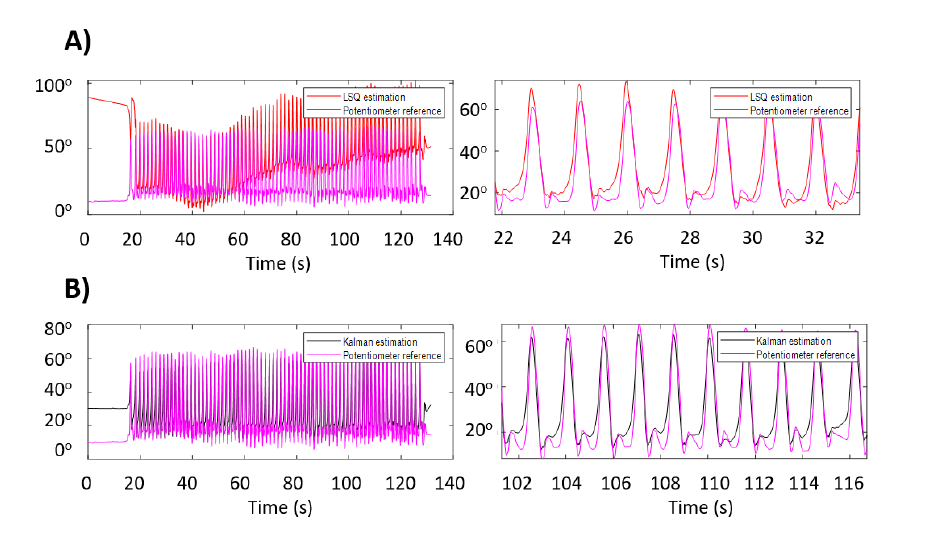
Figure 7. Knee rotation angle by means of the LSQ algorithm ( A ) and Extended Kalman filter algorithm ( B ) using the IMUs located on the leg with parallel